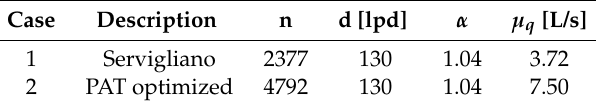
Table 3. Characteristics of the analyzed